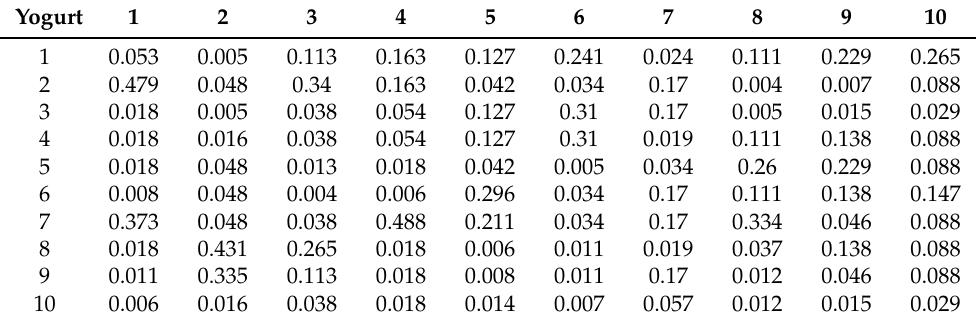
Table A35. Normalization matrix of yogurt.